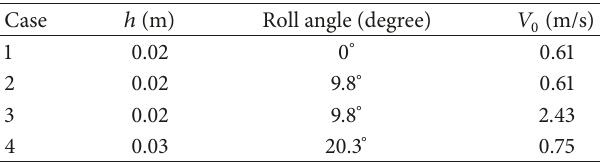
Table 1: Numerical simulation